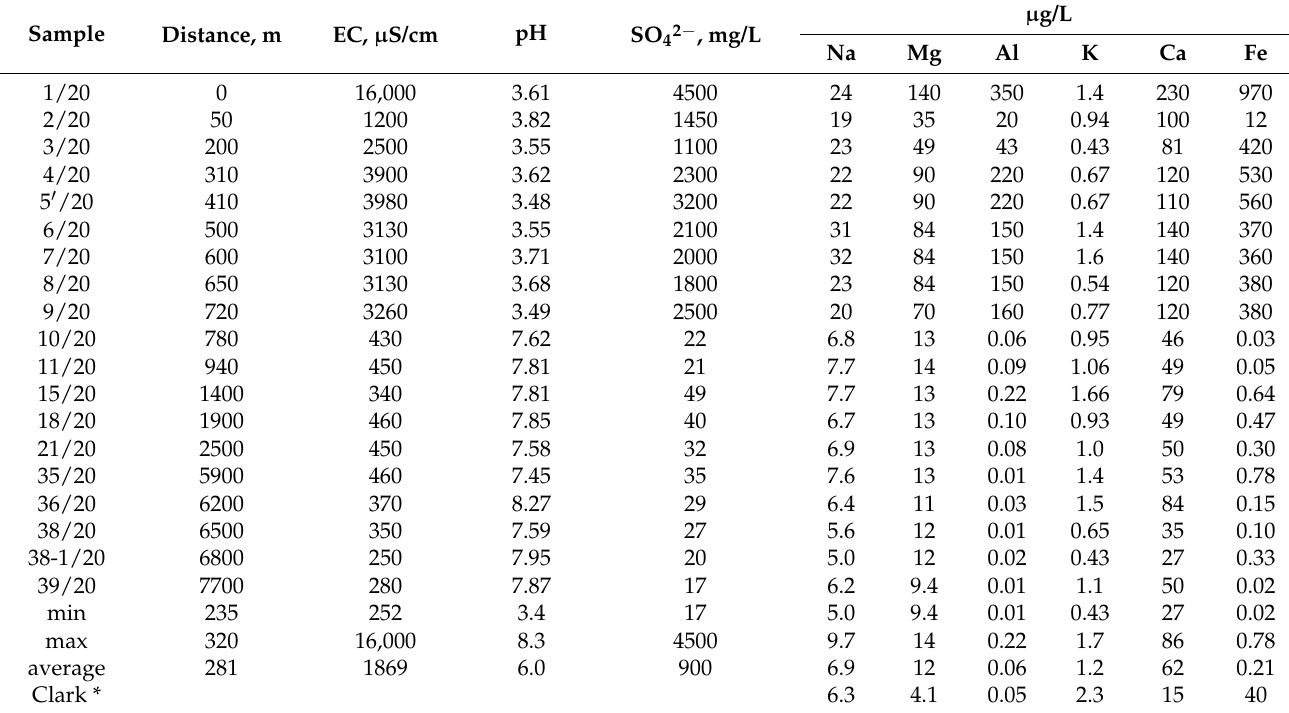
Table 2. Specific conductivity (EC), pH, and concentrations of sulfate and major cations in samples from surface watercourses in the Ursk dump